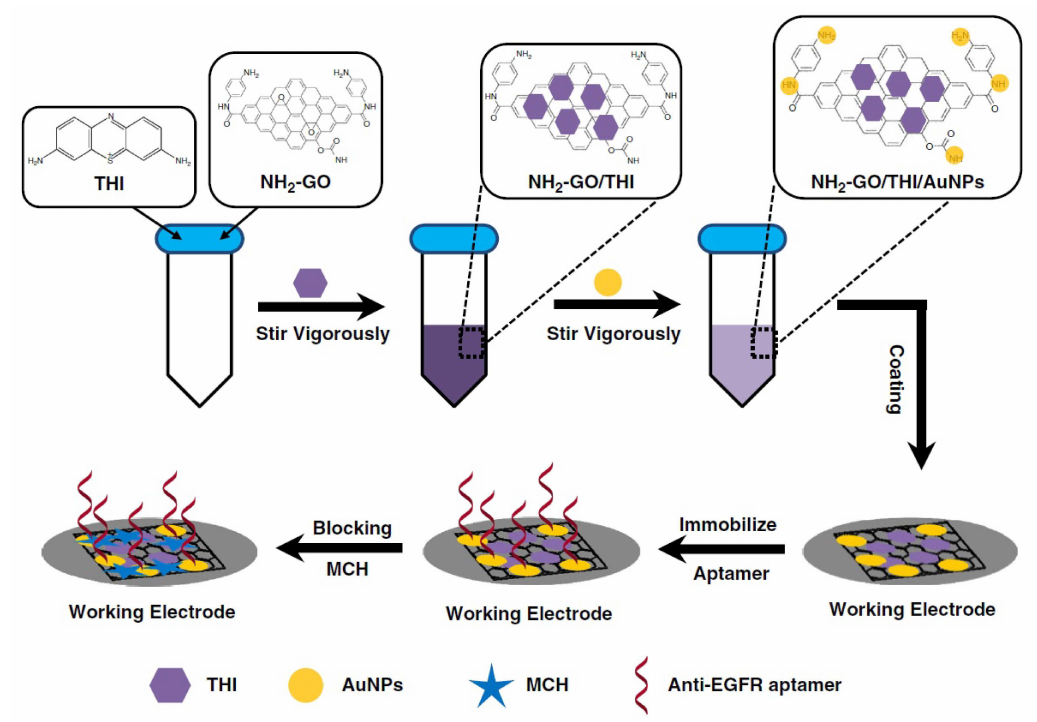
Figure 10. The construction of the origami paper-based aptasensor surface. Reprinted with permis- sion from Ref. [97]. Copyright 2020, this article is licensed under a Creative Commons Attribution 4.0 International